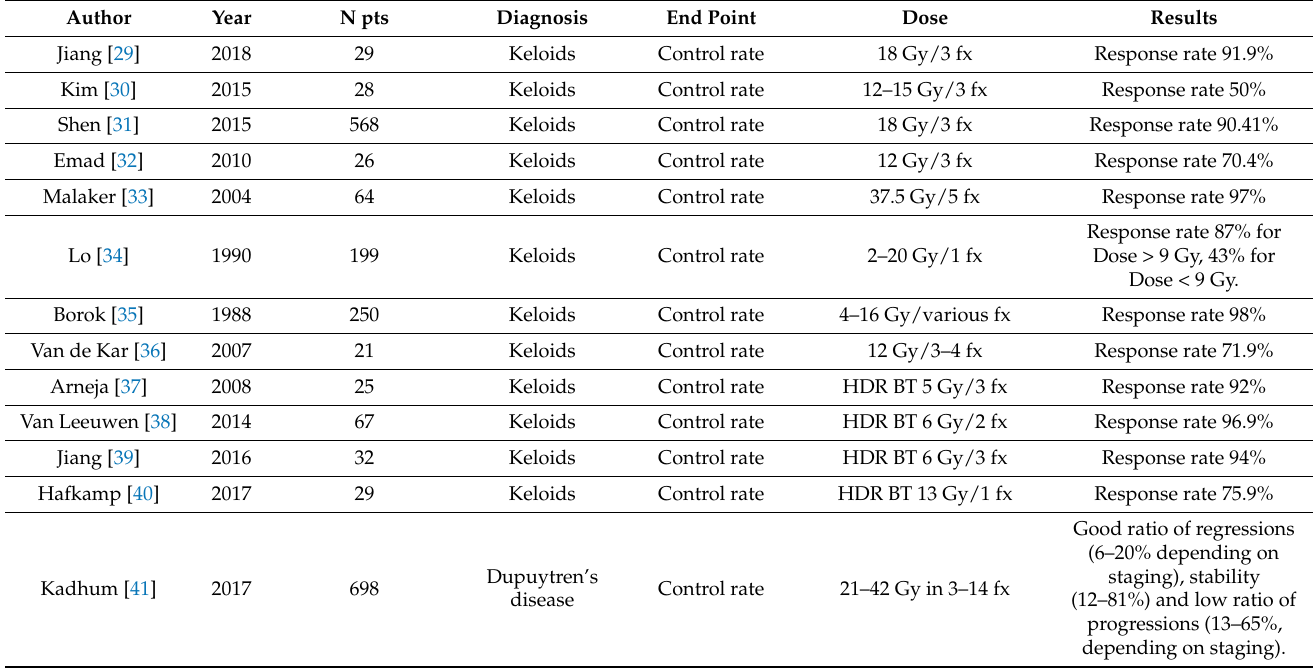
Table 2. Soft tissue disorders: included study and radiotherapy